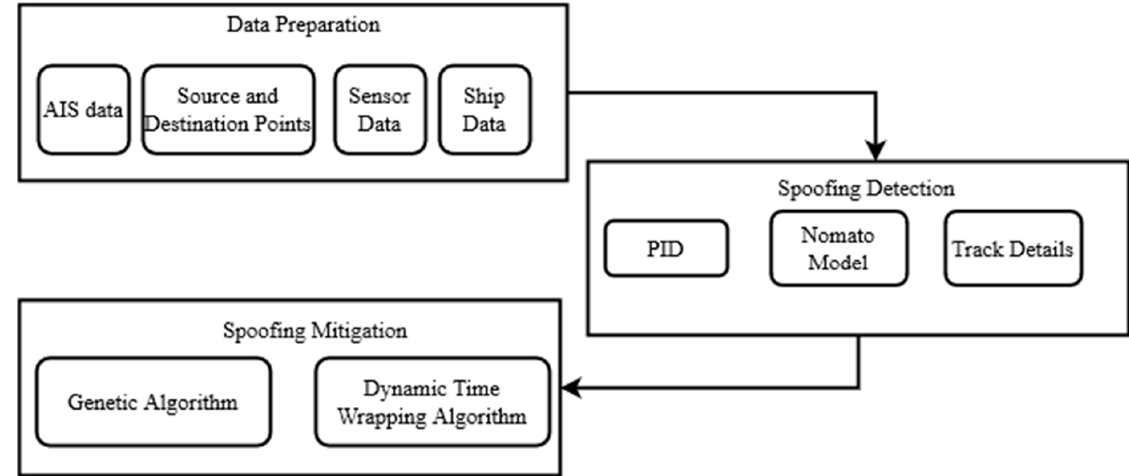
Figure 1. Steps involved in proposed approach.